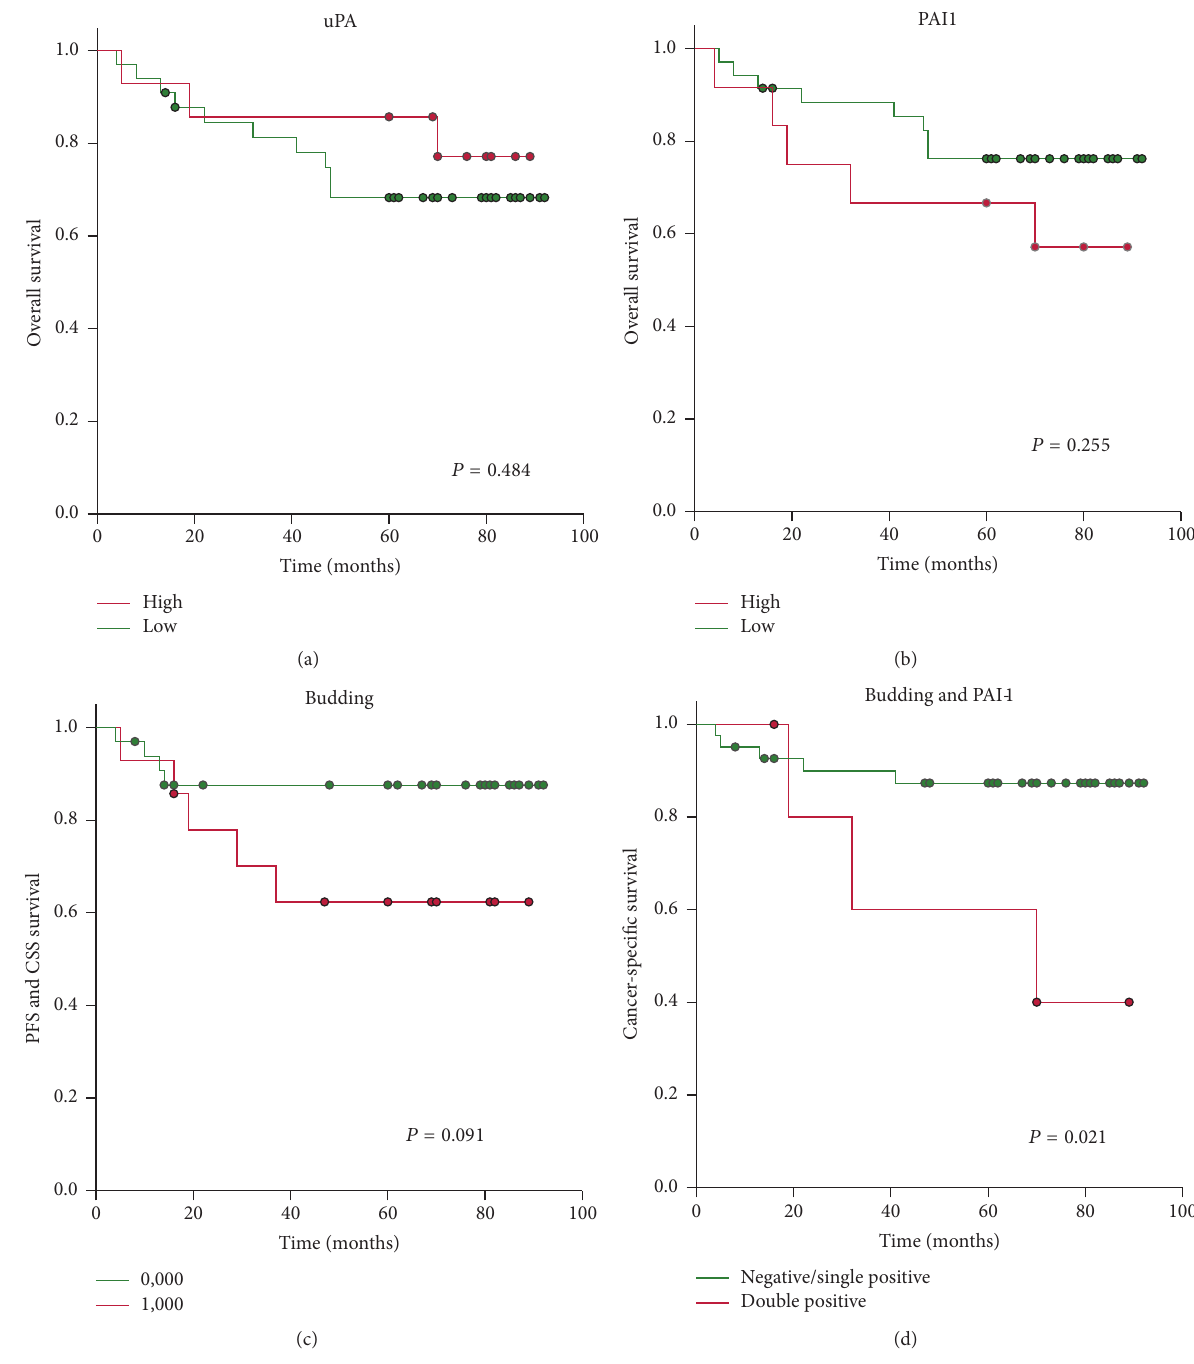
Figure 1: Test set: cancer specific survival of (a) uPA, (b) PAI-1, (c) tumor budding, and (d) a combination of tumor budding and PAI-1 (no or one positive versus double positive). Cut-offs: uPA ≥ 4.0 ng/mg protein; PAI-1 ≥ 40 ng/mg protein; tumor budding ≥ 30 buds/20-fold